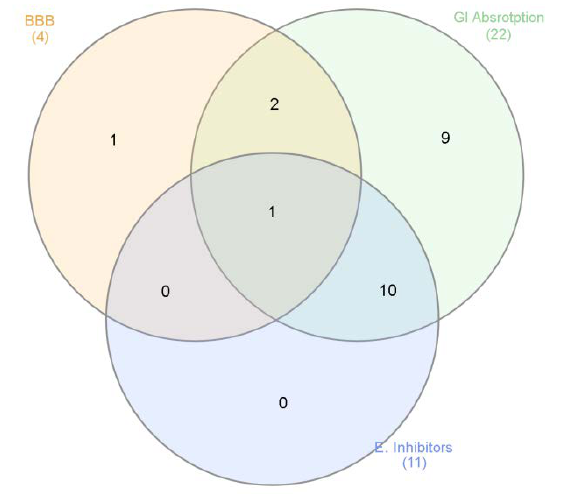
Figure 5. Venn diagram summarizing the criteria for selecting extracts’ phytochemicals, basing on pharmacokinetics (Gastrointestinal (GI) absorption and blood brain barrier (BBB) crossing) and biological properties (enzyme inhibition).